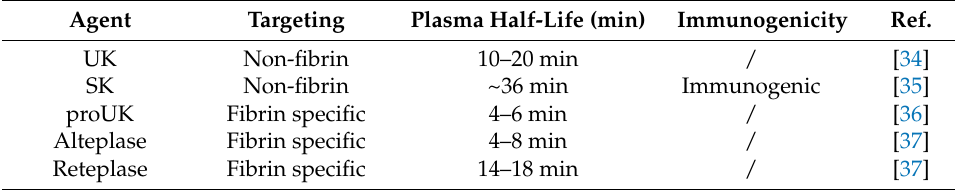
Table 1. Characteristics of thrombolytic agents.